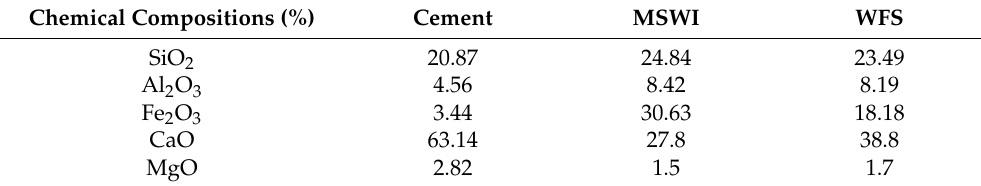
Table 2. Chemical compositions of Portland cement type I, MSWI, and WFS.